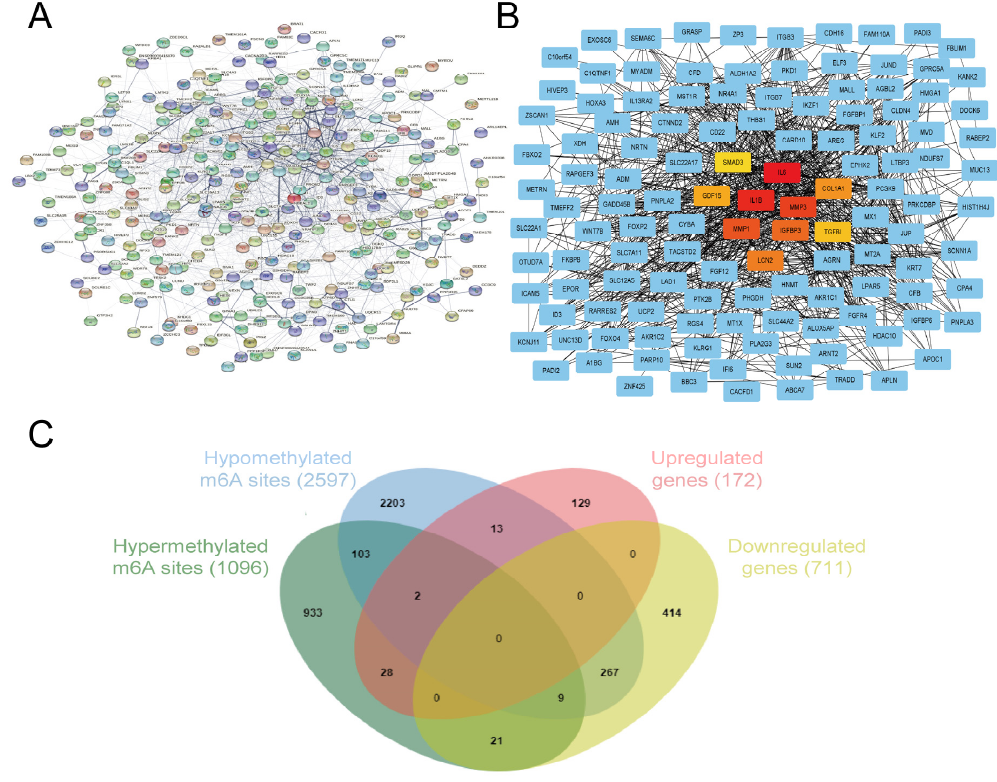
Figure 6. Identification of hub genes and conjoint analysis of RNA-Seq and MeRIP-Seq: ( A ) The PPI network of the differentially expressed genes. ( B ) The 10 hub genes calculated by cytoHubba. ( C ) The intersection analysis of RNA-Seq and